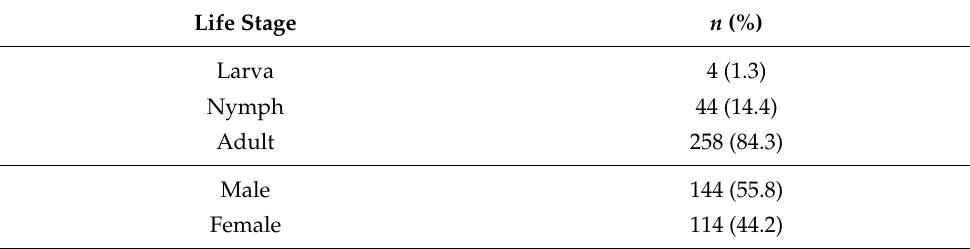
Table 2. Life stage and sex of R. sanguineus s.l. ticks